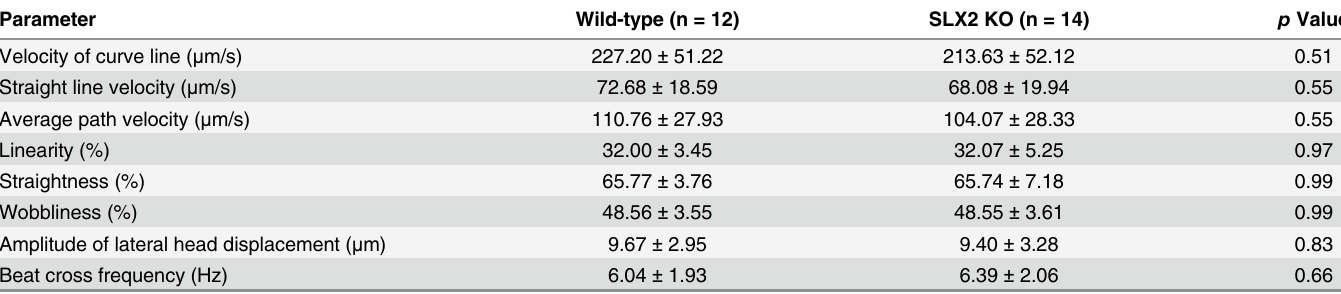
Table 1. CASA analysis of sperm motility